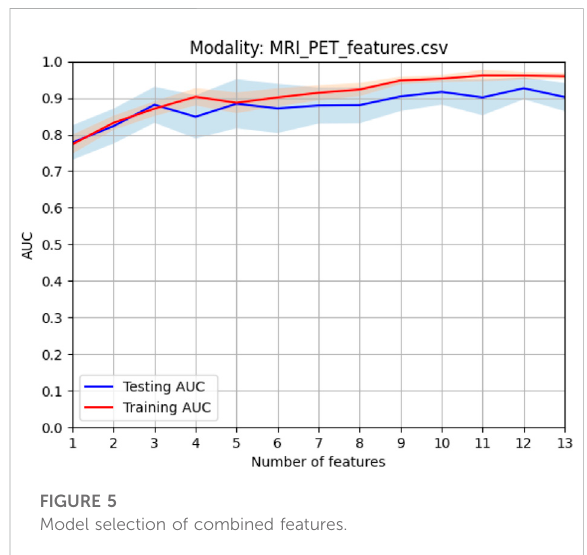
FIGURE 5 Model selection of combined features.